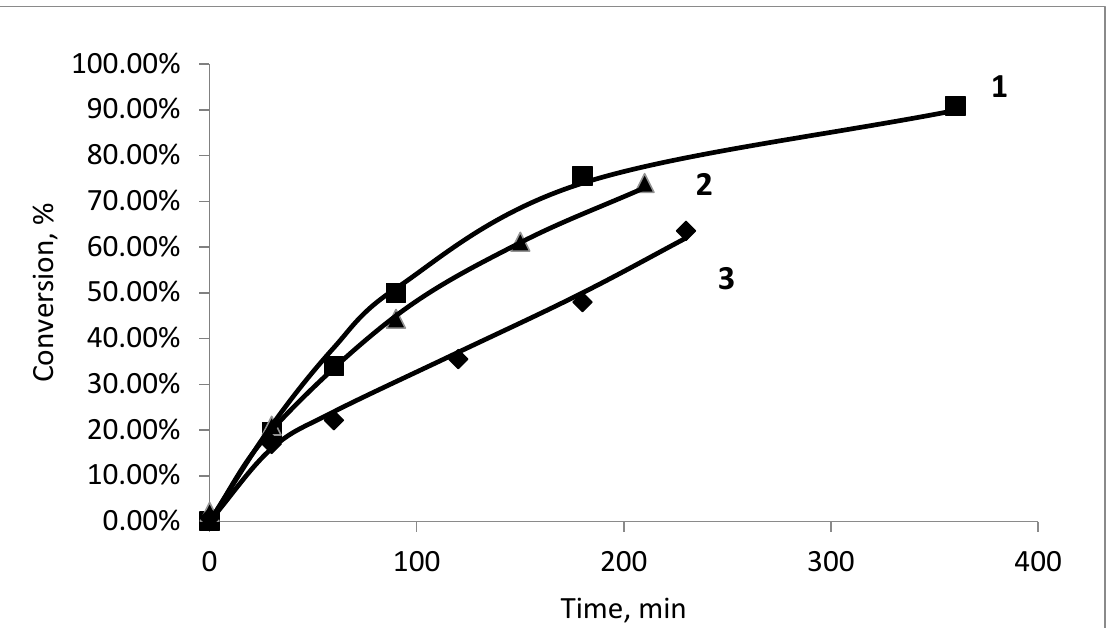
Figure 11. Hydroamination of phenylacetylene with aniline over Au@meso-UiO-66 without solvent. Phenylacetylene: aniline molar ratio is 1:2. 1 . 1st cycle; 2 . 2nd cycle; 3 . 3rd cycle.